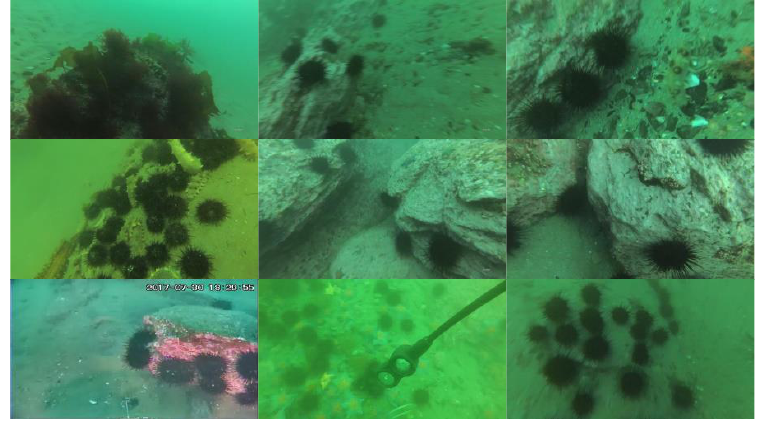
Figure 6. Example of a dataset image.